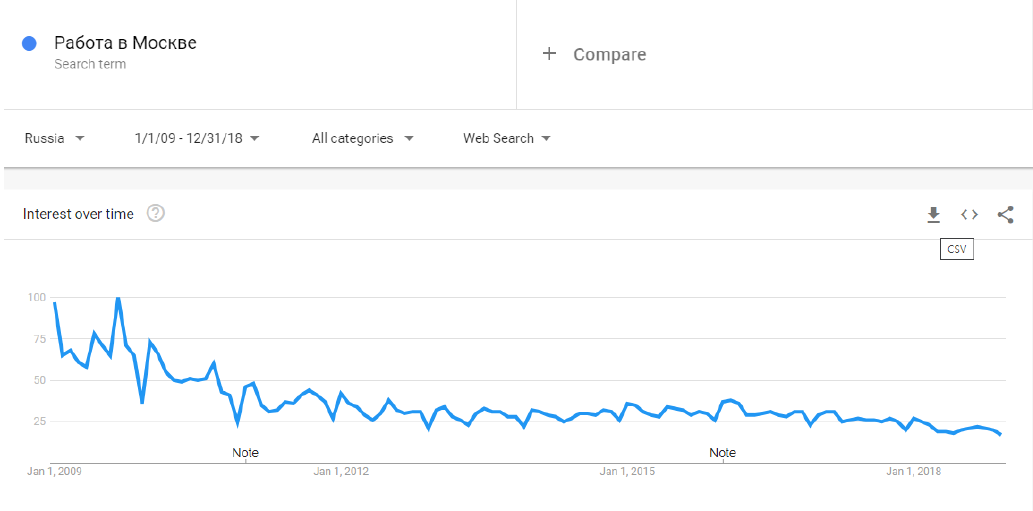
Figure A1. Google Trends data for the keywords “ Работа в Москве ”, searched in Russia. Sample: 01/01/2009–31/12/2018.